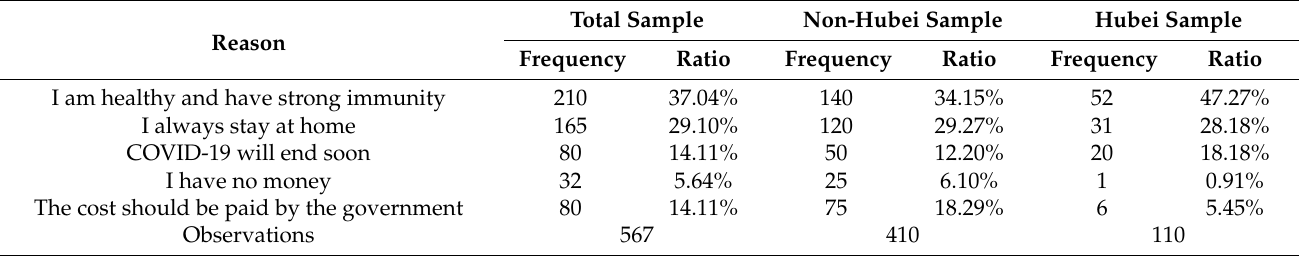
Table 6. Reasons of unwilling to